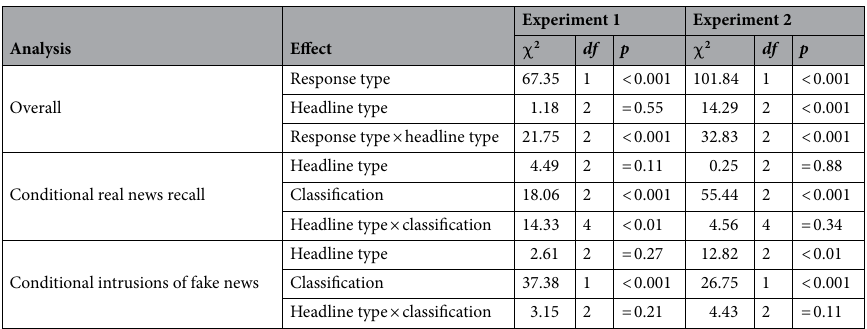
Table 2. Model results for beliefs in real news recall and intrusions of fake news in Phase 3. The results above correspond to the data visualized in Fig. 5 (for overall recall) and Fig. 6 (for conditional